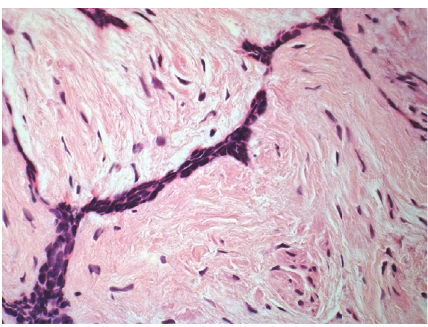
Figure 5: Follicular and acanthomatous cell patterns.